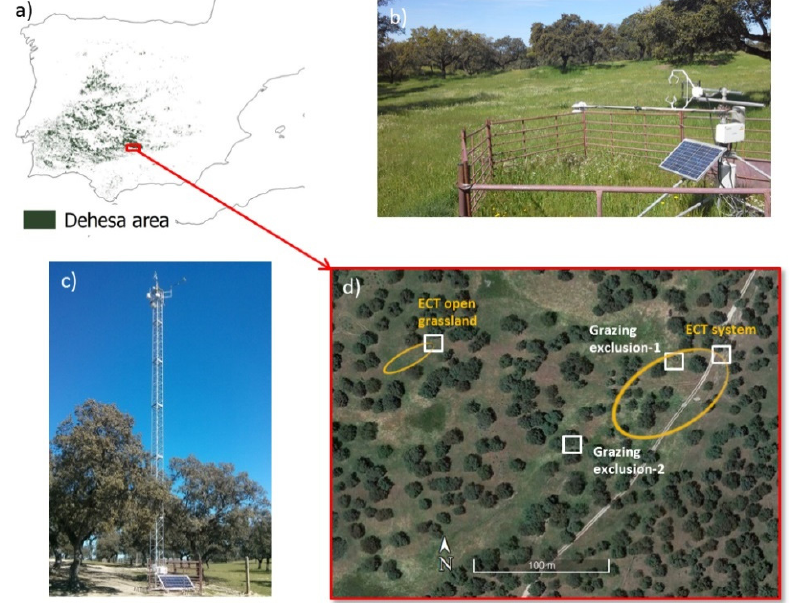
Figure 1. ( a ) Distribution of the dehesa ecosystem in the Iberian Peninsula (in green) and the study area location ( b ) Eddy covariance tower (ECT) over open grassland. ( c ) ECT over the combined tree + grassland system; ( d ) Aerial photograph showing the locations of validation sites.